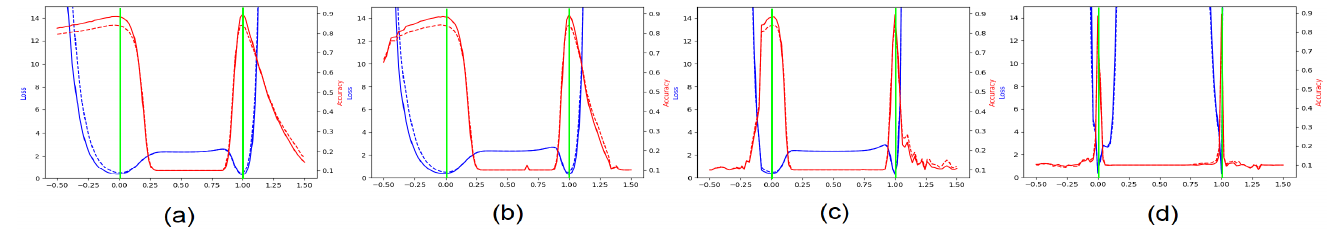
Figure A4. ( a ) Loss/accuracy profiles obtained by linearly interpolating between two optimized VGG A and B . Network A is for x = 0 and B for x = 1 (green vertical lines). Dotted lines are for training and solid lines for validation. Remaining plots are similar interpolations but between teleported versions of A and B with CoB range σ of ( b ) 0.6, ( c ) 0.9, and ( d ) 0.99.